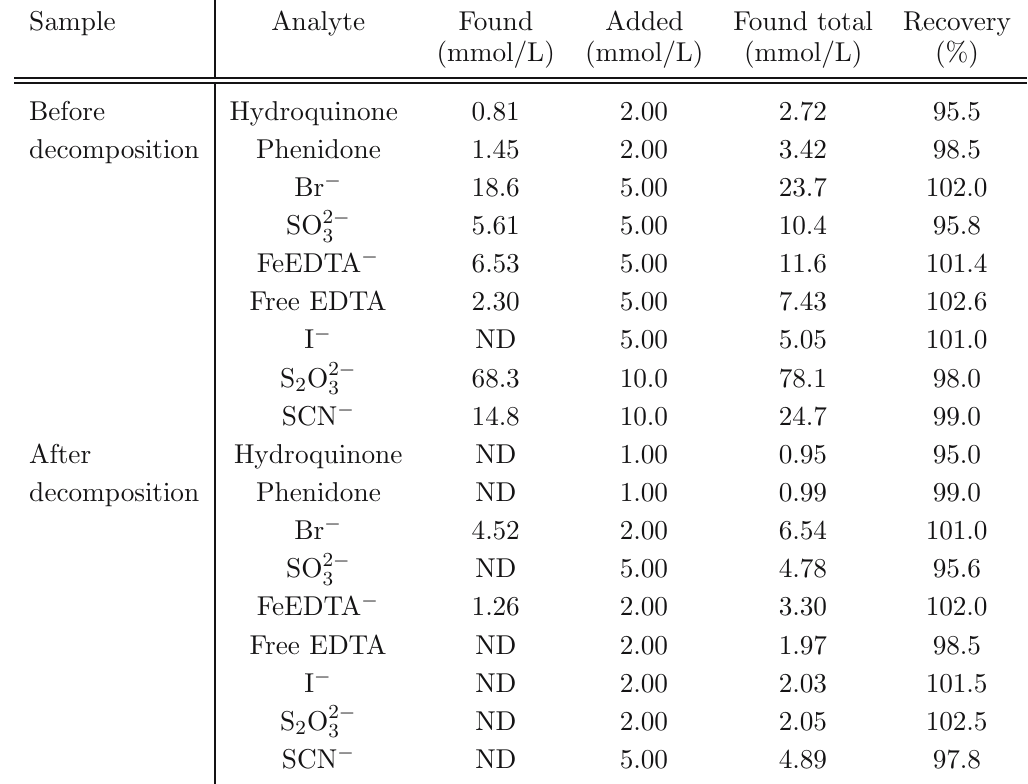
Table 2 Results of the IPC determination of main contaminants in photographic effluents (n =